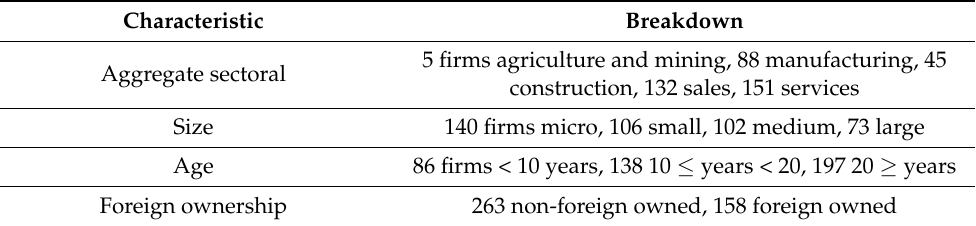
Table 2. Breakdown of the sample by different